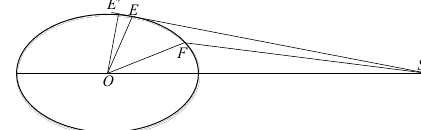
Figure 2. Sectional view of satellite’s area